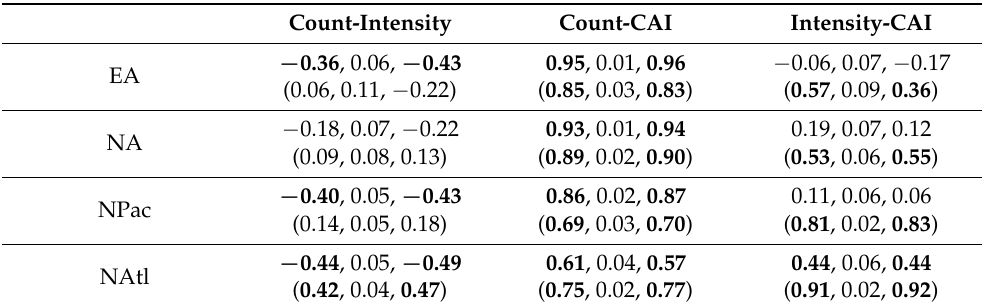
Table 2. Statistics related to correlation coefficients among the linearly de-trended cyclone indices averaged over the four regions (Eurasia, North America, North Pacific, and North Atlantic) for the period from 1951 to 2010. Three numbers over each region, in turn, indicate the average and standard deviation of the 80 correlations calculated from the ensemble members and the correlation calculated from the ensemble average indices. Numbers outside and inside parentheses are results in JFM and JAS, respectively. The effective sample size is found to be at least 52 for the 60 seasonal series in these calculations. The 5% significance level of a correlation is r > 0.27 for 52 degrees of freedom. The number in bold indicates a correlation significant at the 5% level. Count-Intensity Count-CAI